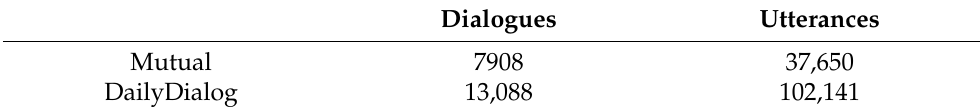
Table 1. Dataset for